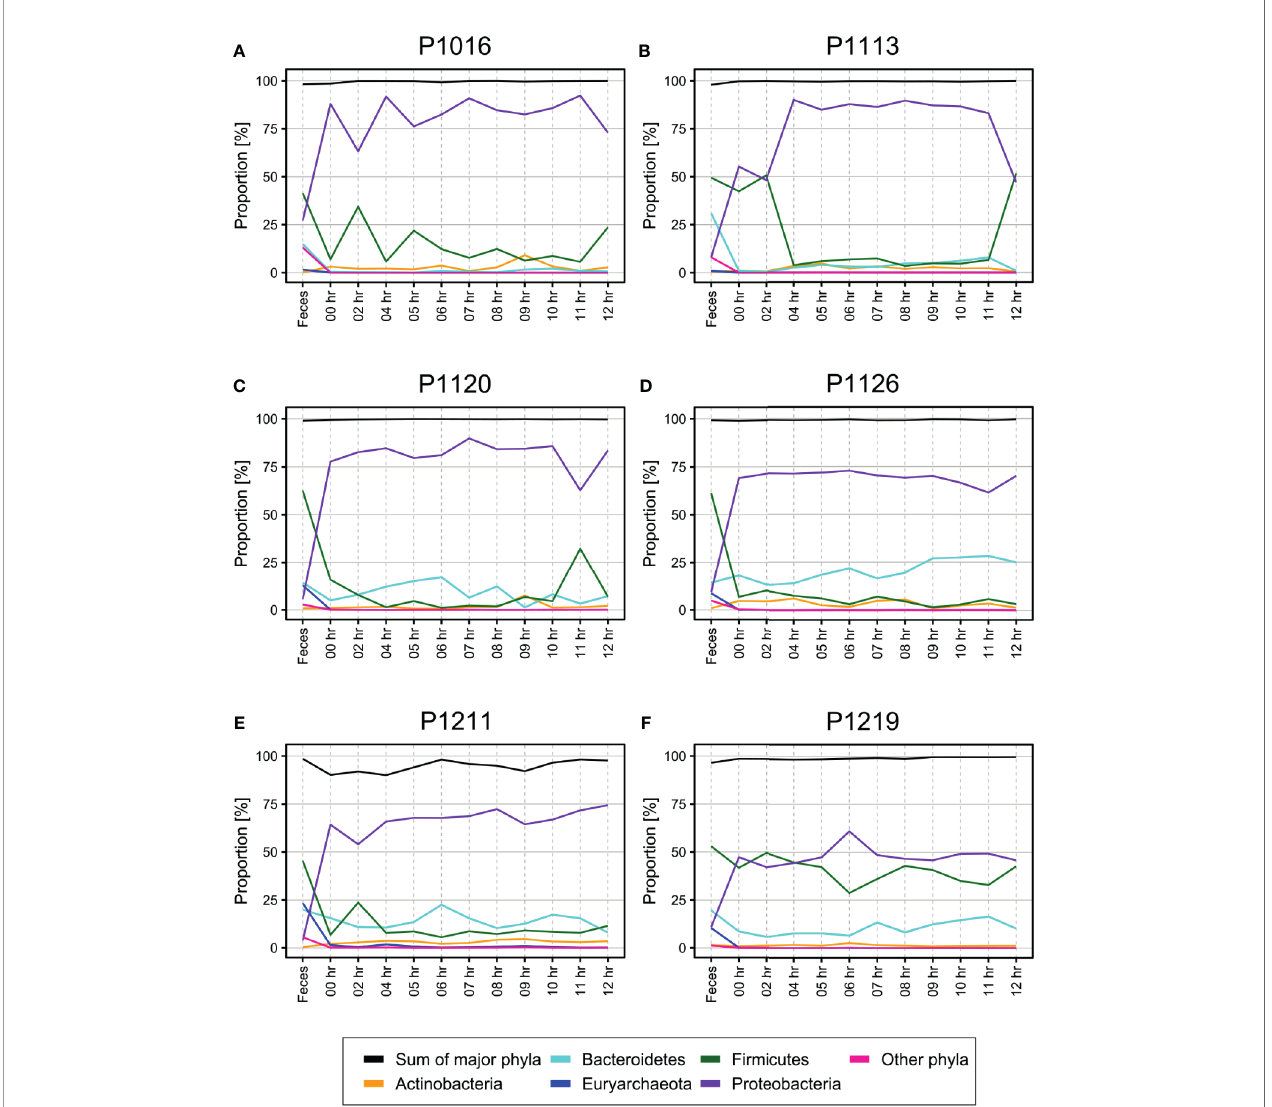
FIGURE 1 | (A – F) Percentage of operational taxonomic units (OTUs) from each phylum identi fi ed in the blood of pigs with fecal-induced peritonitis. The proportion of each phylum in the blood microbiome was maintained throughout the induction period, which was different from the observations for the fecal microbiome. Although Proteobacteria was the major phylum identi fi ed in the blood, its percentage contribution varied in each of the six animals tested. The proportions at the genus level are shown in Supplementary Figure 2